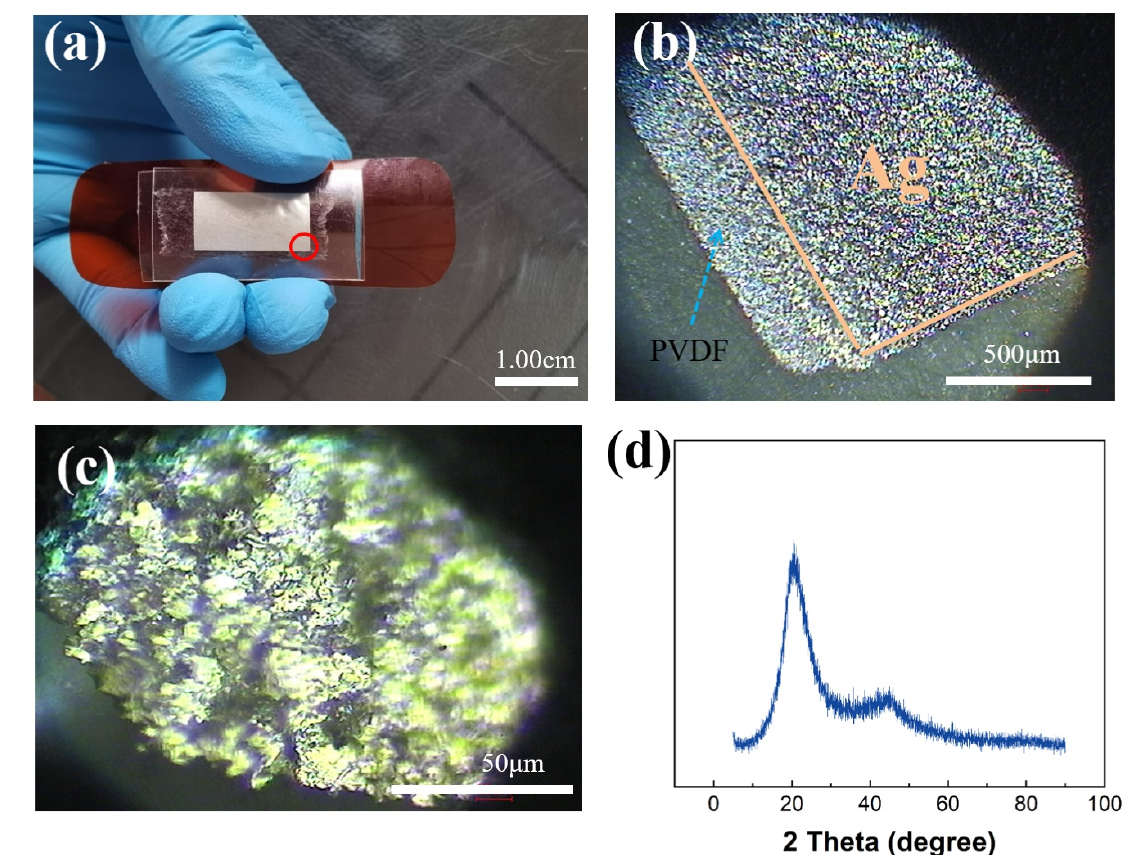
Figure 2. ( a ) Optical image of the sensor. ( b , c ) The topography of the sensor under different magnifications under an optical microscope. ( d ) XRD graph for PVDF.